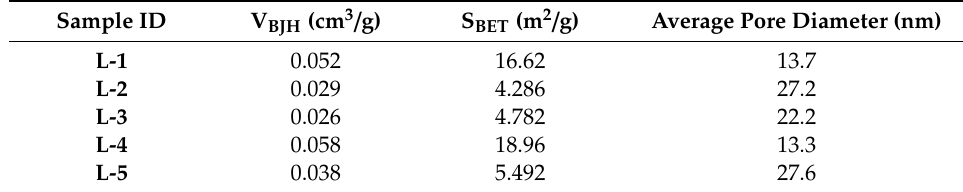
Table 2. Pore parameters of samples calculated from N 2 adsorption data.